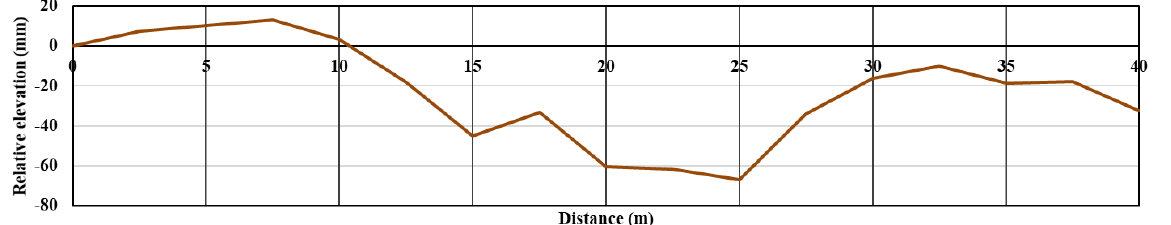
Figure 8. Water level at location ( a ) 5.21 m, ( b ) 14.53 m, ( c ) 18.12 m, ( d ) 23.27 m, ( e ) 30.38 m, ( f ) 38.05 m in CCTV.